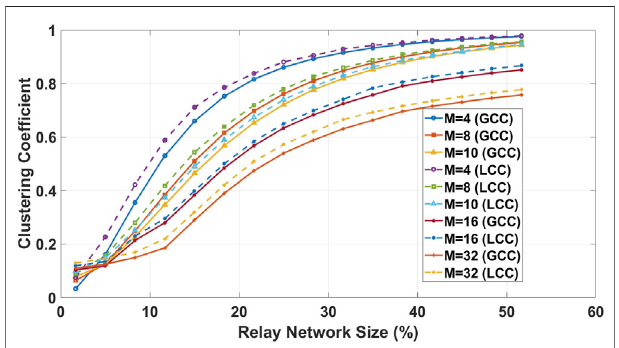
FIGURE 13 | Local and global clustering coef fi cient for a BA network with N = 10 000